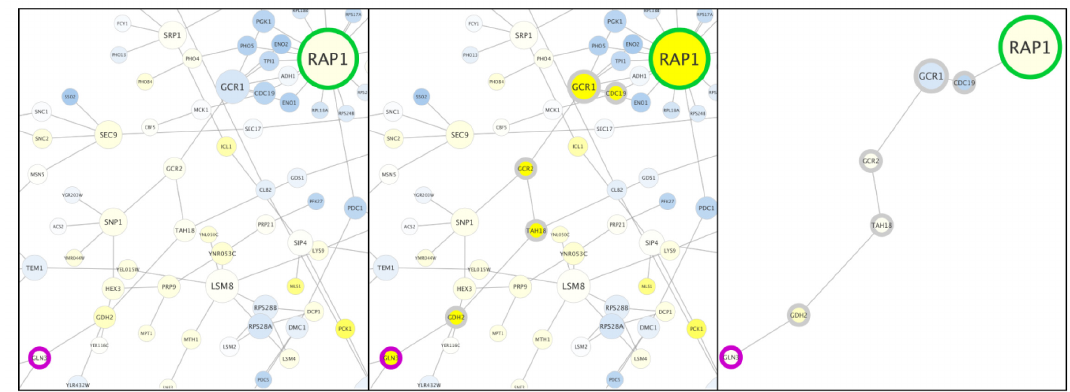
Figure 3. Visualizing shortest path results. In Cytoscape, the start and finish nodes were colored green and magenta, respectively (left panel). The shortest path calculated by RBGL was then selected and nodes along the path were highlighted with thick borders (middle panel). Finally, a subnetwork was created from the selected path (right panel). Note that while common gene names are displayed as node labels, official yeast identifiers are the actual node names that are referenced in the